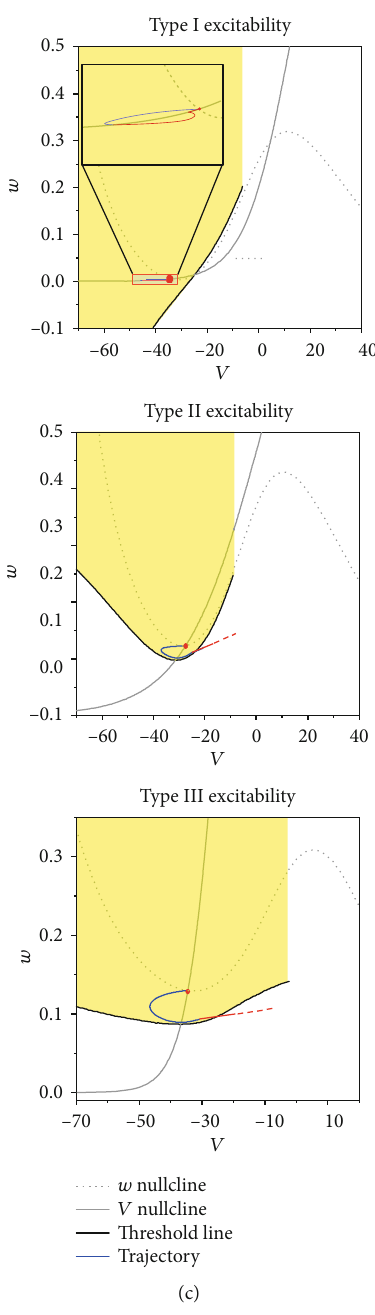
Figure 10: The dynamics for 3 types of excitability: (a) the threshold curve (black solid curve), the w nullcline (gray solid curve), the V nullcline (grey dotted curve), and the stable equilibrium point (red circle); (b) phase trajectory (red) of the subthreshold oscillations induced by the inhibitory stimulation plotted with the (a); (c) an excitatory stimulation is applied at a phase point in the ascending part of the subthreshold oscillations (the initiation point of the red curve). (a1, a2, a3) Type I excitability for I app = 38 μ A/cm 2 ; G inh = 1 mS/cm 2 ; G ex = 1 : 1 mS/cm 2 ; insert in (a3) represents the enlargement of the phase trajectory. (b1, b2, b3) Type II excitability for I app = 87 : 3 μ A/cm 2 ; G inh = 0 : 5 mS/cm 2 ; G ex = 1 mS/cm 2 . (c1, c2, c3) Type III excitability for I app = 200 μ A/cm 2 ; G inh = 0 : 6 mS/cm 2 ; G ex = 2 : 5 mS/cm 2